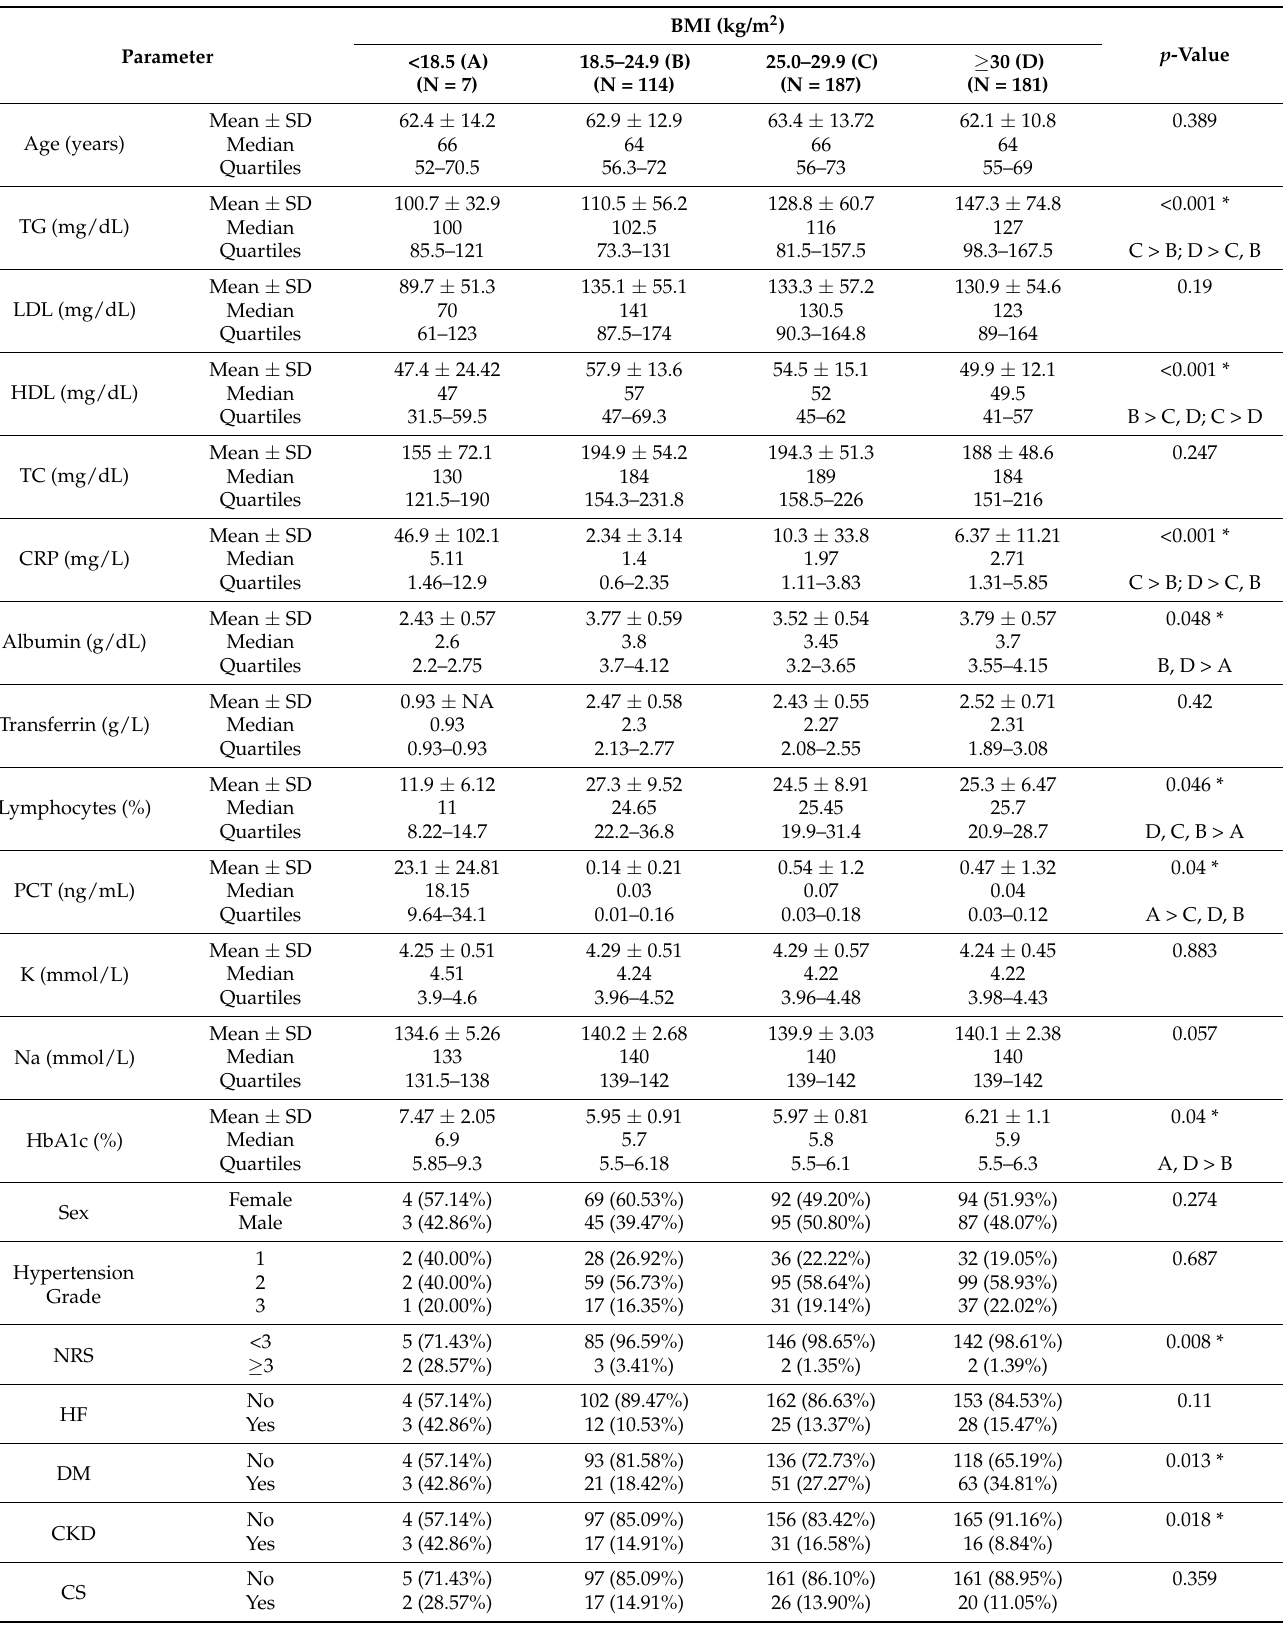
Table 3. Comparison of the assessed parameters according to BMI status (qualitative and quantita- tive